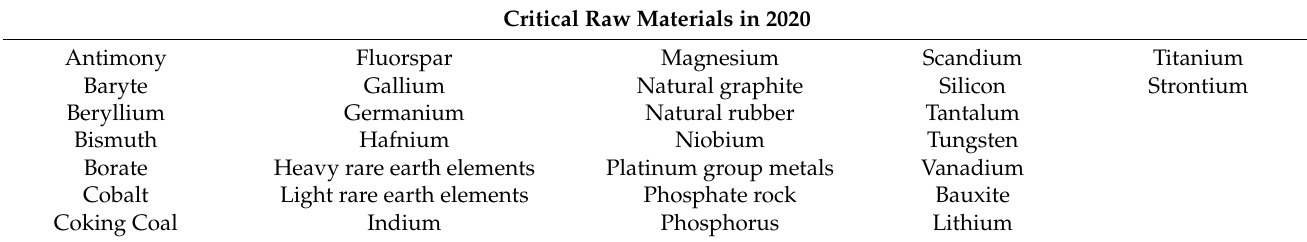
Table 1. Critical raw materials list